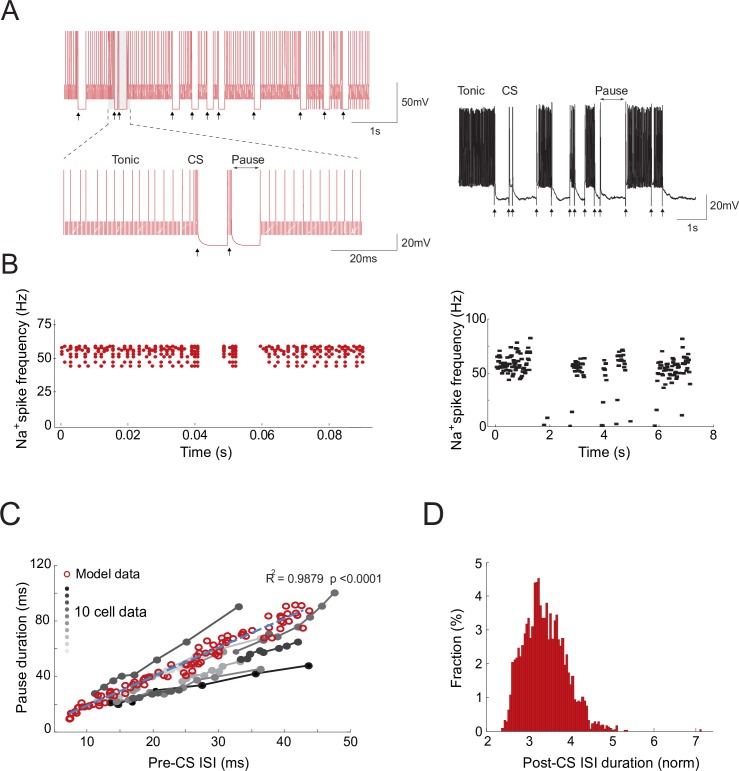
Spike burst–pause properties of model Purkinje cell responses.(A) Simulated (left) and electrophysiological (right) recordings of Purkinje cell spike outputs in response to CF spike excitatory postsynaptic potentials occurring at physiological frequencies (arrows) (data from [41]). CF discharges trigger transitions between Purkinje cell Na+ spike output and CF-evoked bursts and pauses via complex spikes. Here, the Purkinje cell model was run on the EDLUT simulator (see Methods). (B) Simulated (left) and experimental (right) Purkinje cell tonic spike frequency during CF discharges aligned with spike-grams in A (data from [41]). N = 10 Purkinje cells were simulated to compute the tonic spike frequency. (C) Relation between pause duration and pre-complex spike (pre–CS) inter spike intervals (ISIs) when increasing the amplitude of the injected current: model data (red circles, n = 1000) vs. experimental data [44] (grey to black dots). Grey-to-black lines represent individual cells (n = 10). The blue dashed line is the linear regression curve fitting model data. The model captures the relation between spike pause duration and pre-complex spike ISI duration observed electro physiologically [44]. (D) Distribution of ISI values following the complex spike (post-CS). The ISI duration is normalised to pre-CS ISI values. The Kurtosis for the distribution of post-CS ISI values is 4.24. The skewness is positive (0.6463), thus indicating an asymmetric post-CS ISI distribution. Kurtosis and skewness values were consistent with Purkinje cell data [44].